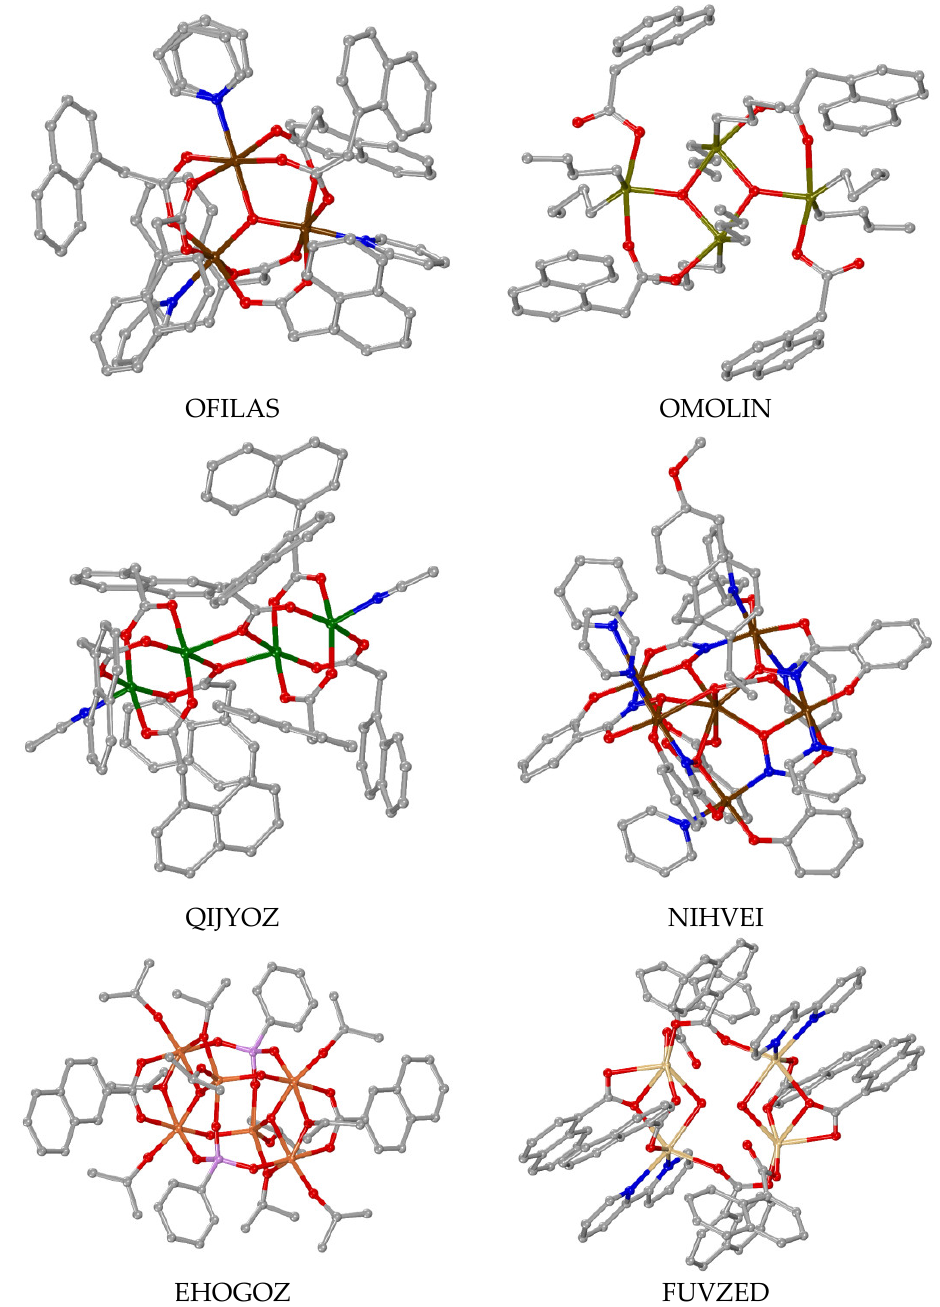
Figure 21. Molecular structures of selected complexes of Table 3. OFILAS = [Mn 3 (µ 3 –O)(µ 2 –N1A–O,O′) 6 (py) 3 ] [86]; OMOLIN = {[( n –Bu) 2 Sn] 2 (µ 2 –N1A–O,O′)(µ 2 –N1A–O,O) (µ 3 –O)} 2 [88]; QIJYOZ = [Cu 4 ( µ 2 –N1A–O,O (cid:48) ) 6 ( µ 2 –N1A–O,O,O (cid:48) ) 2 (CH 3 CN) 2 ] [87]; NIHVEI = [Mn 6 ( µ 3 –NAP–O,O,O (cid:48) )( µ 2 – Hsal–O,O (cid:48) )( µ 2 –shi–N,O) 5 (py) 6 ] [90]; EHOGOZ = [Ti 6 ( µ 3 –O) 2 ( µ 2 –O) 2 ( µ 3 –phenyl–phosphonato) 2 ( µ 2 – isopropoxo) 4 (isopropoxo) 6 ( µ 2 –N2A–O,O (cid:48) ) 2 ] [89] and FUVZED = [Cd 4 ( µ 2 –N1A–O,O (cid:48) ) 4 ( µ 2 –N1A– O,O,O (cid:48) ) 2 (N1A–O) 2 ( µ 2 –H 2 O) 2 (bipy) 2 ] [84]. Color code for atoms: C: gray, O: red, N: blue, Mn: brown; Sn: dark yellow; Cu: green; Ti: orange; P: pink and Cd: yellow. The figures of the structures were adapted from the corresponding references.